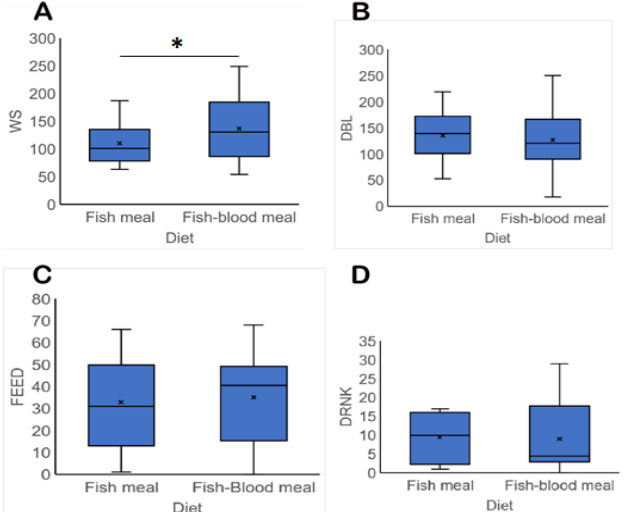
Figure 2: Box plots showing the range of data and standard deviations for the frequency of chicken’s behaviour in each group: (A) WS, walking and standing; (B) DBL, dust bathing or lying; (C) FEED, feeding; and (D) DRINK, drinking. Both groups were similar in terms of the frequency of normal behaviours, except for in (A) where group provided with blood meal supplement showed higher WS activity than the fish meal only group.